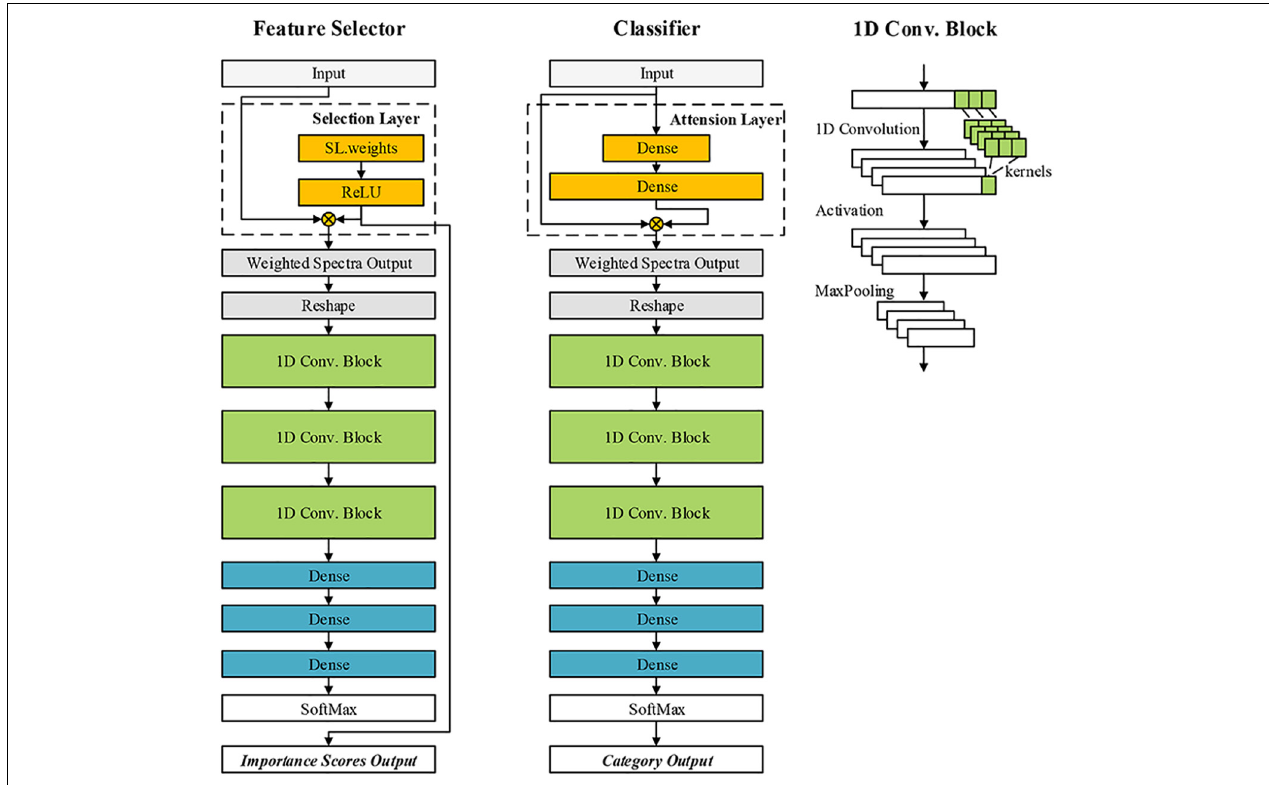
FIGURE 4 | The architectures of the proposed convolutional neural network (CNN)-based models for classification and feature selection.